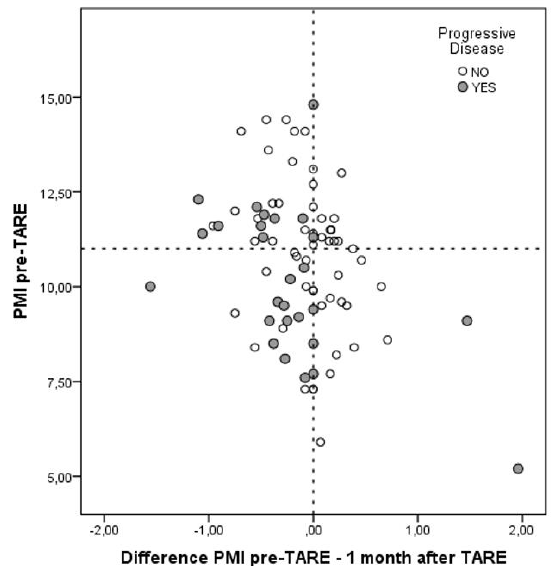
Figure 3. Distribution of the entire population according to the initial PMI value and the delta-PMI at one month.